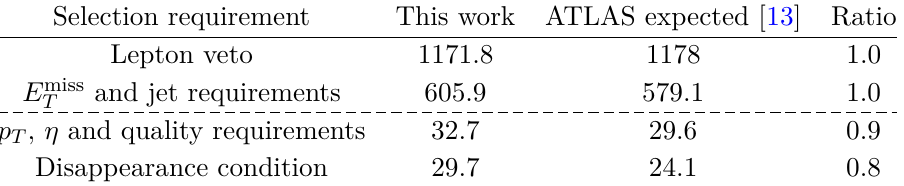
, τ ) = (400 GeV , 0 . 2 ns) , χ ± χ ±